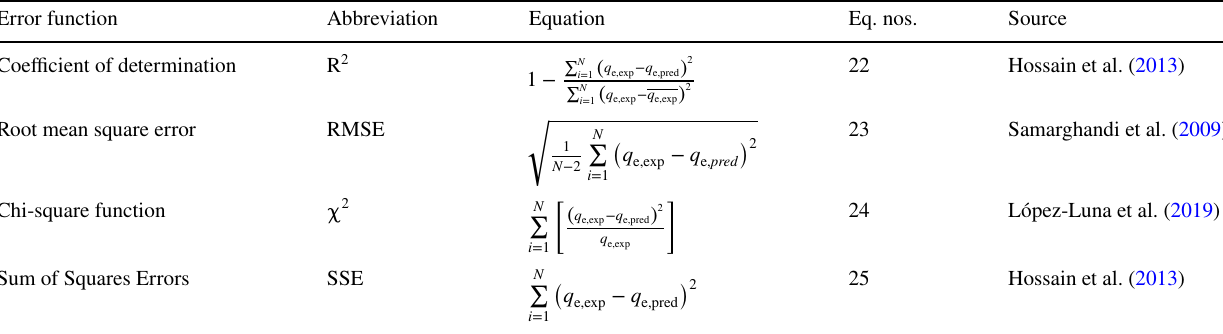
The subscripts “exp” and ‘pred” represent the experimental and predicted values, and N is the number of observations in the experimental Table 3 Physical properties of raw rice husk and RHAC samples